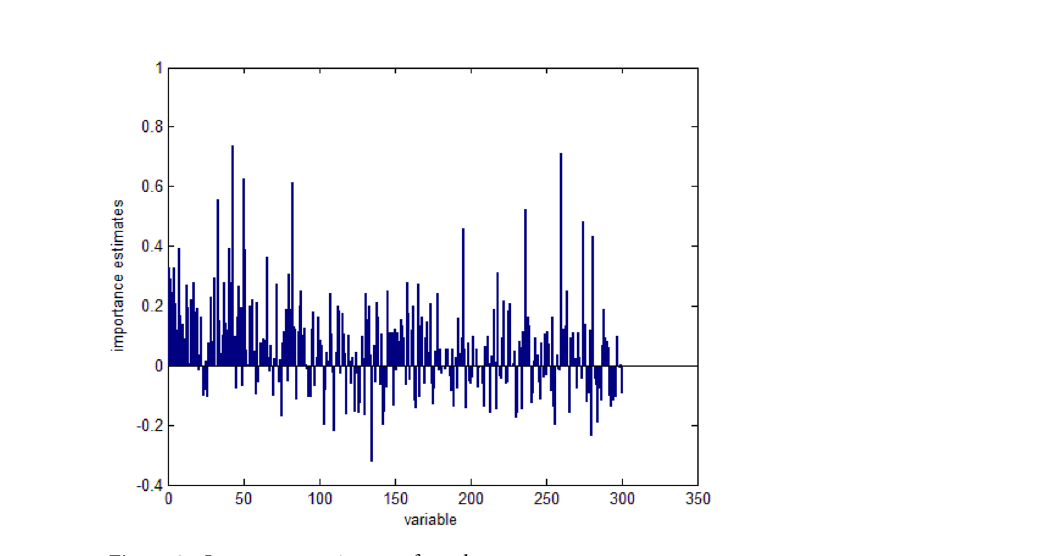
Figure 8. Importance estimates of